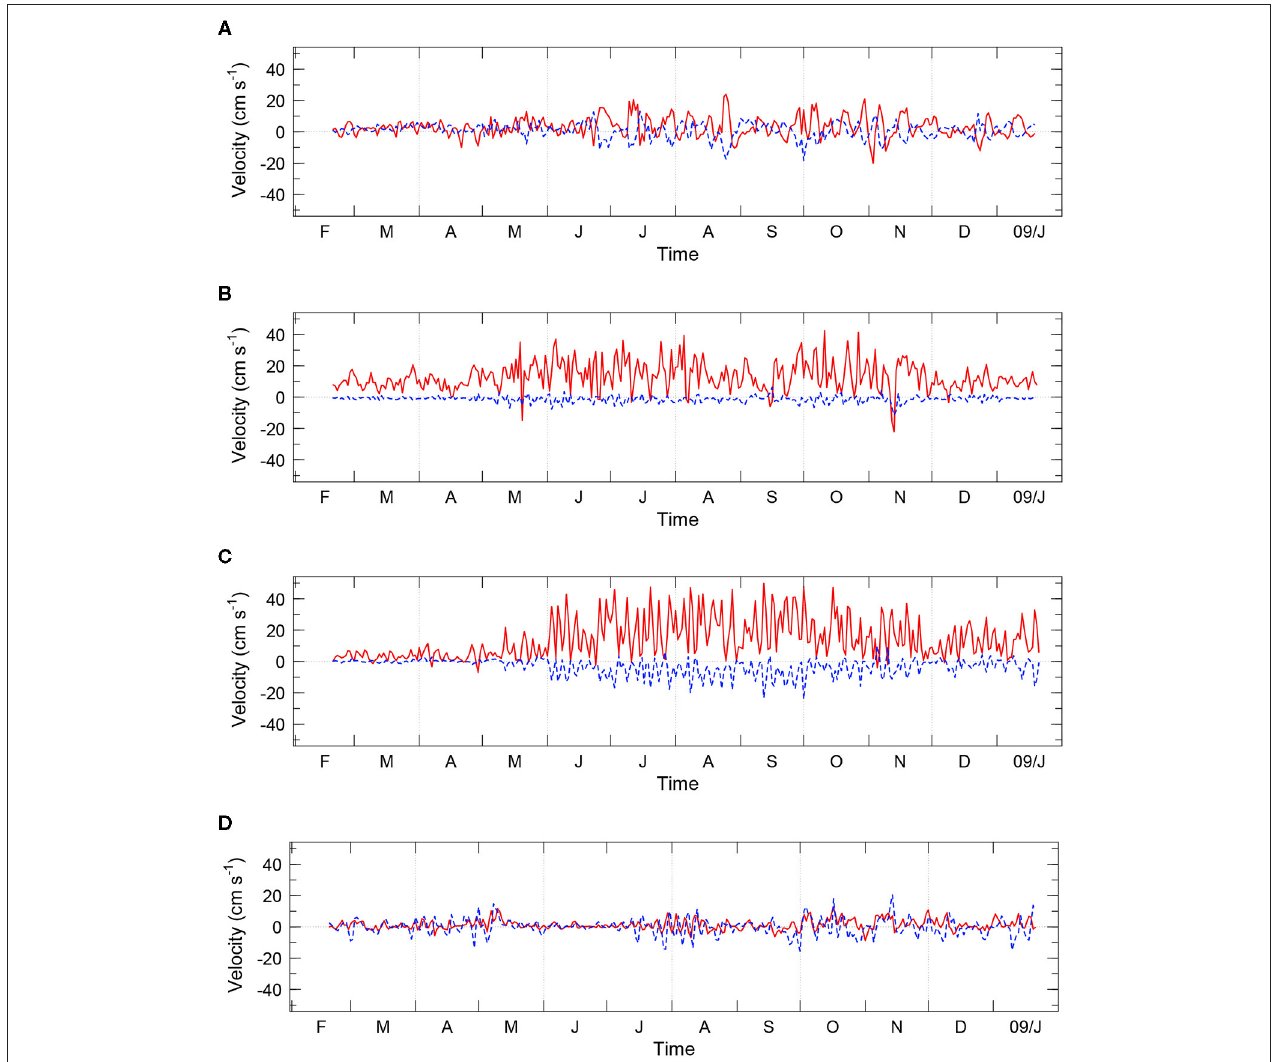
FIGURE 5 | Time series of the along-isobath velocity, u ′ , (red line) and across-isobath velocity, v ′ , (blue dashed line) for the deepest velocity data at mooring (A) M1, (B) M2, (C) M3, and (D) M4.